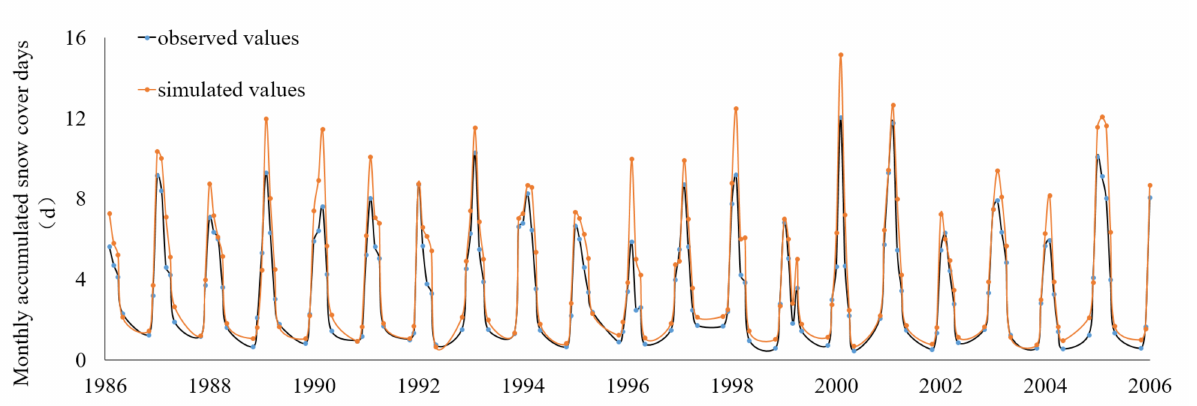
Figure 7. Variation of simulated and observed snow cover days per month.